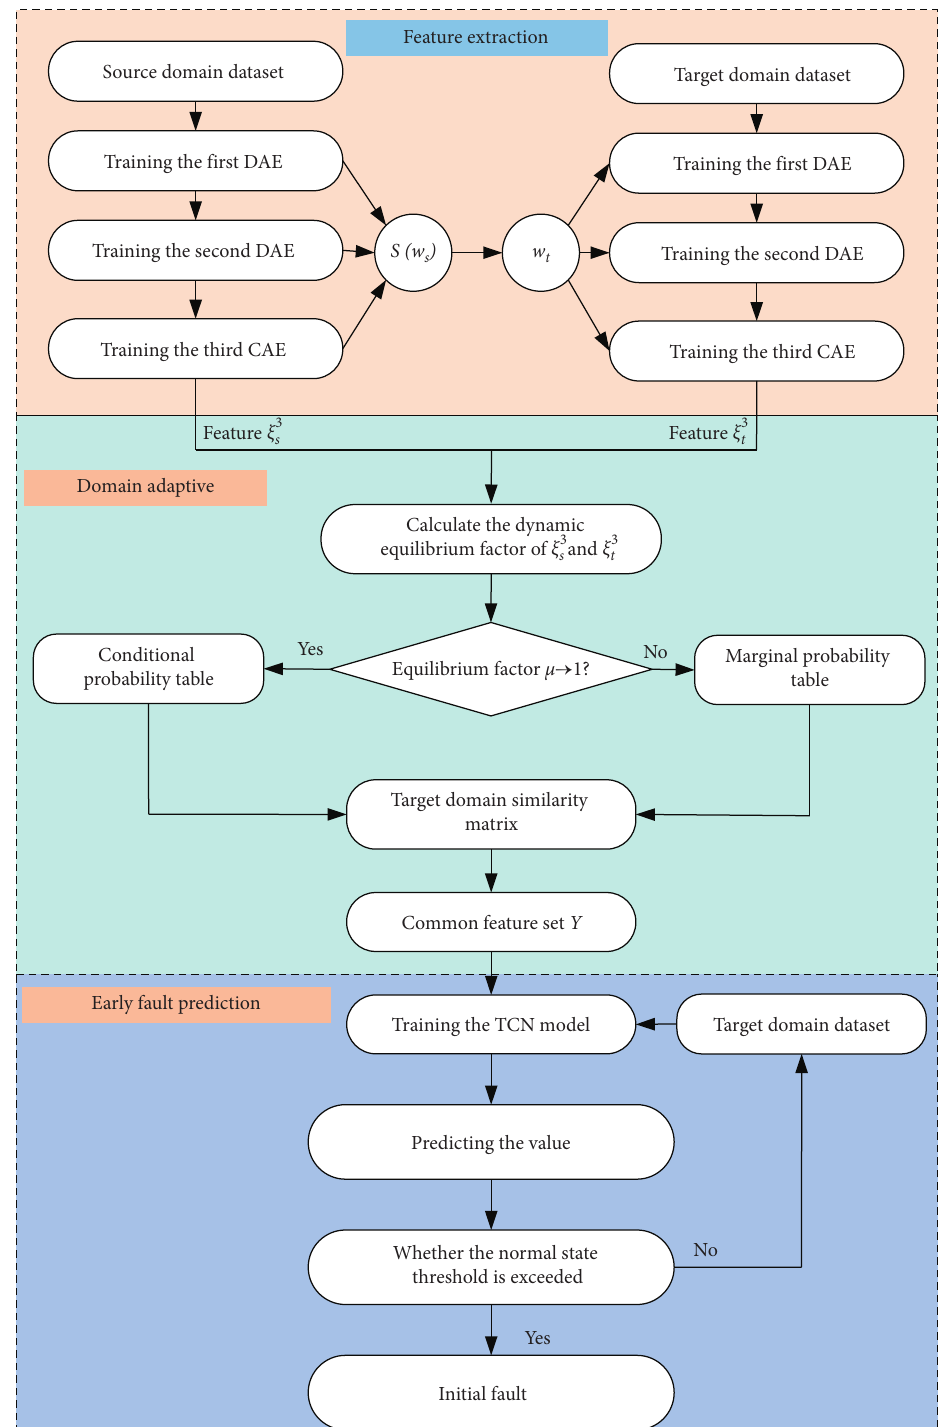
Figure 4: Flowchart of the rolling bearing initial fault prediction